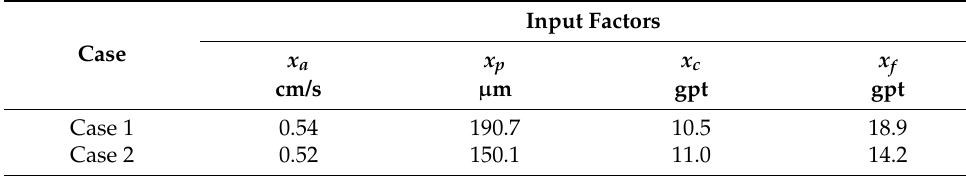
Table 8. Optimal values of input variables for Case 1 and Case 2.